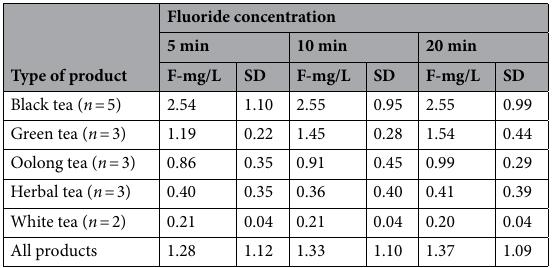
Table 2. The concentration of fluoride from the different types of tea infusions after 5, 10, and 20 min of brewing